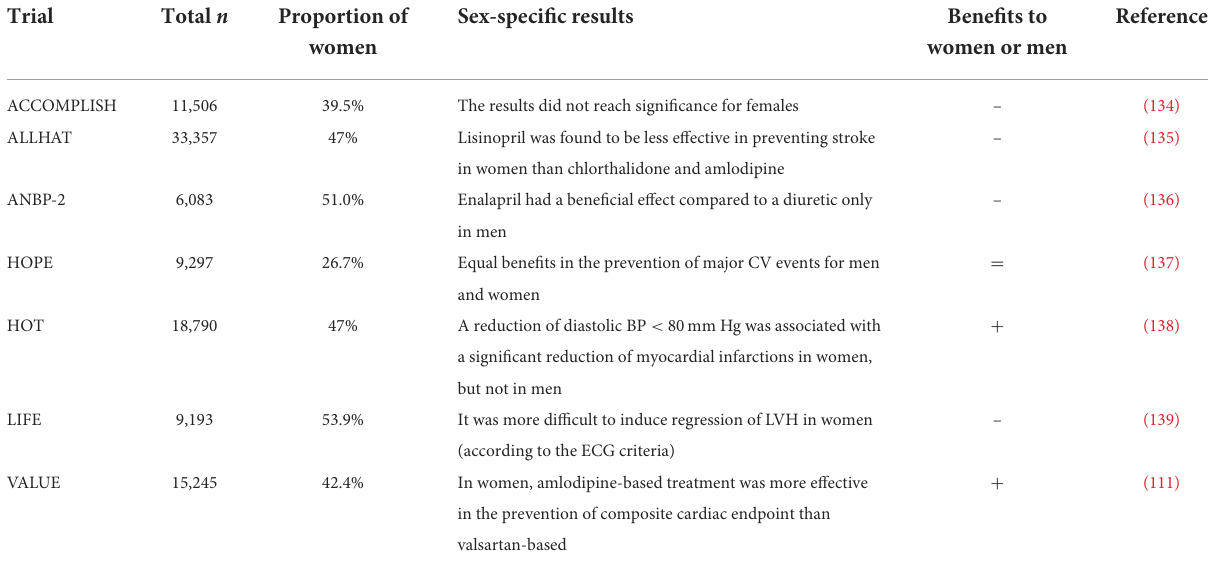
TABLE 3 Sex-specific results of key trials of antihypertensive treatments (in alphabetical order).